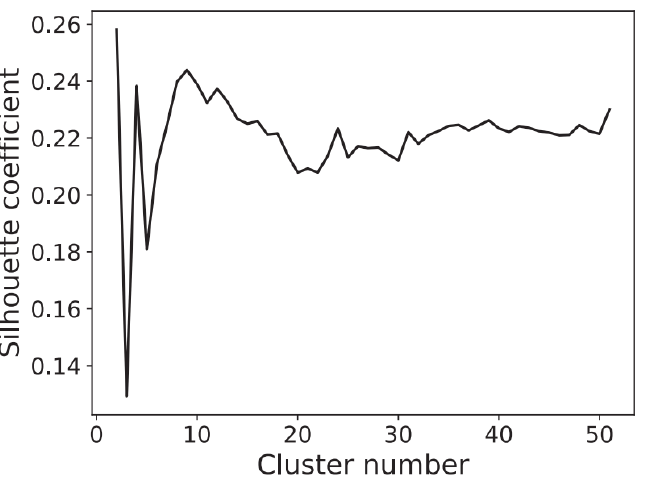
Figure 1. Identification of optimal number of meteorological states using silhouette coefficient with the hierarchical clustering algorithm.